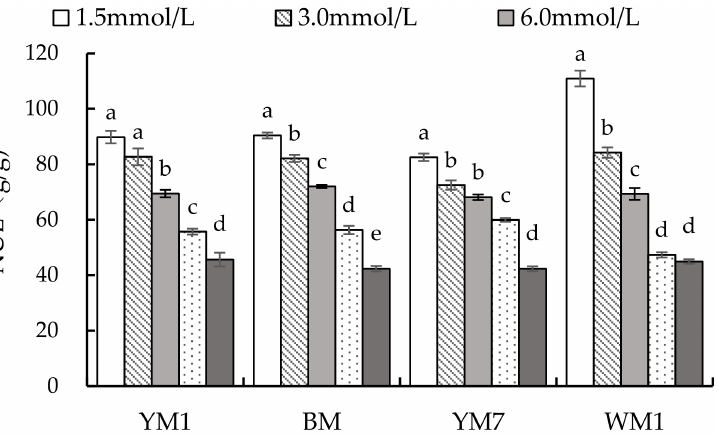
Figure 3. Effect of N treatments on N utilization efficiencies in hemp. Different letters above the columns within a cultivar represent significant differences in N utilization efficiencies at p =